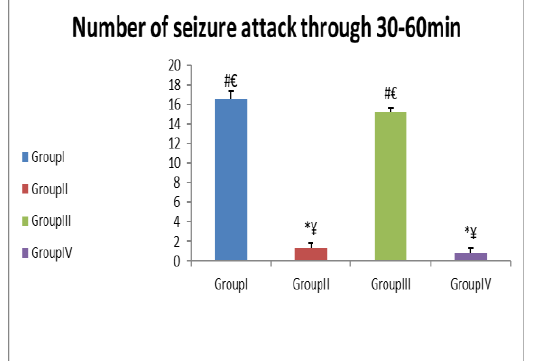
Figure 1. Mean±SE of the onset of clonic seizures(min) that induced by yohimbine HCl (Group I) and other treated groups, Diazepam+ yohimbine HCl (Group II), omega 3 fatty acids +yohimbine HCl (Group III) and omega3fatty acids +Diazepam +yohimbine HCl (Group IV). Symbol *refers to difference between group I and other groups. Symbol; # refers to difference between group II and other groups; symbol ¥ refers to difference between group III and other groups; and symbol € refers to difference between group IV and other groups.